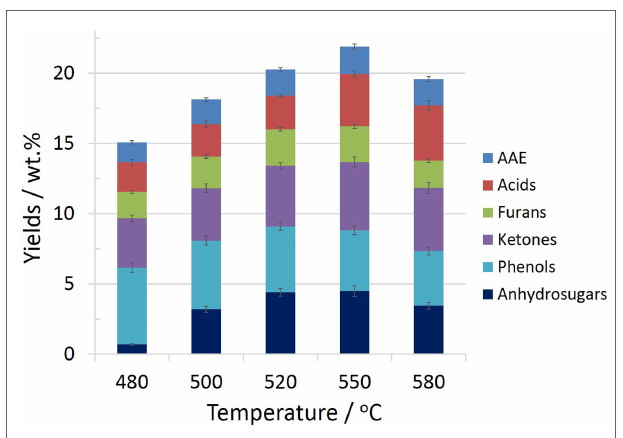
FigUre 4 | influence of temperature on the lumped classes of pine pyrolysis bio-oils